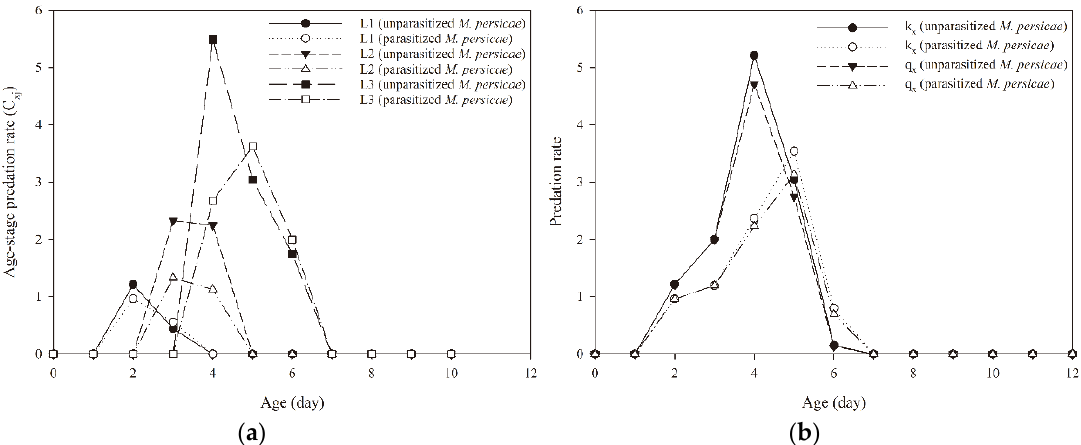
Figure 3. Age-stage, two-sex predation rate ( c xj ) ( a ) and age-specific predation rate ( k x ) ( b ), age-specific net predation rate ( q x ) ( b ) of immature Aphidoletes aphidimyza that fed on unparasitized and parasitized Myzus persicae by Aphidius gifuensis.